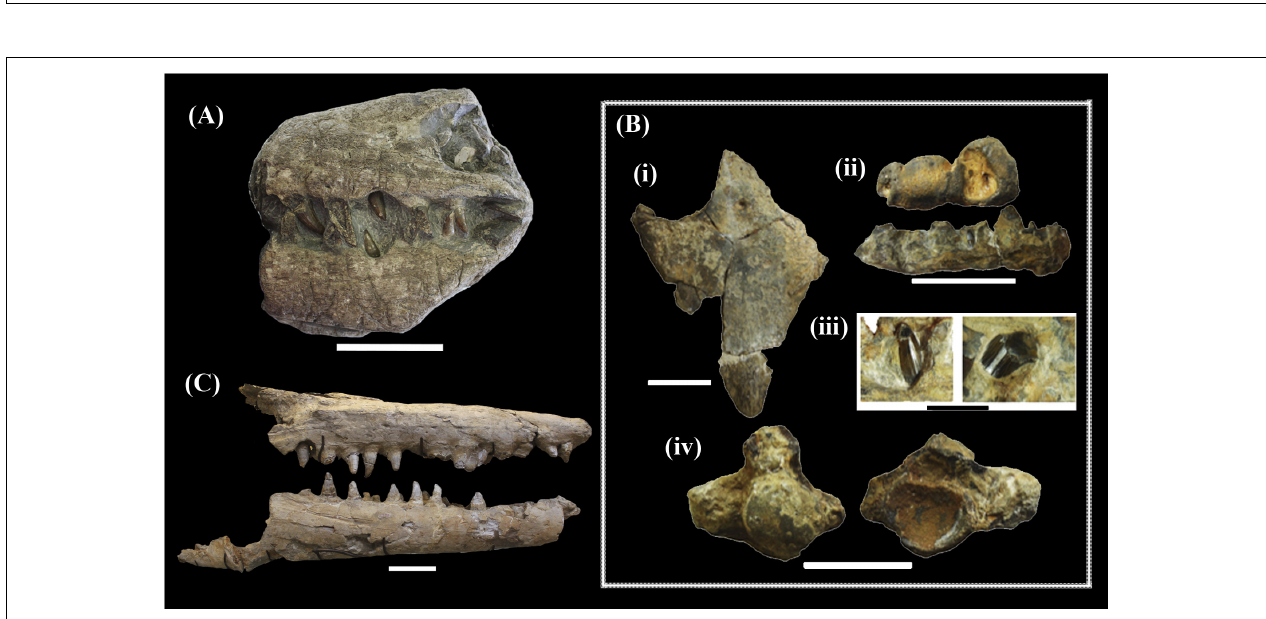
FIGURE 9 | The problematic taxa: (A) holotype of Ta. ‘mikasaensis’ reassigned to Taniwhasaurus indet. 1, from de Santonian – early Campanian of Hokkaido, Japan MCM.M0009, scale bar equal to 100 mm; (B) holotype of former “ Tylosaurus capensis ,”, reassigned to Taniwhasaurus indet. 2, from the Santonian of Pondoland, South Africa SAM-PK-5265: (i) frontal with fragments of parietal and both postorbitofrontals, scale bar equal to 10 cm; (ii) jaw fragments, scale bar equal to 100 mm; (iii) close up of replacement teeth, scale bar equal to 20 mm; (iv) cervical vertebra, left shows in condyle view, right shows in cotyle view, scale bar equal to 50 mm; (C) holotype of Tylosaurus gaudryi from the Santonian of Éclusier-Vaux, France MNHN 1896-15, scale bar equal to 100 mm.